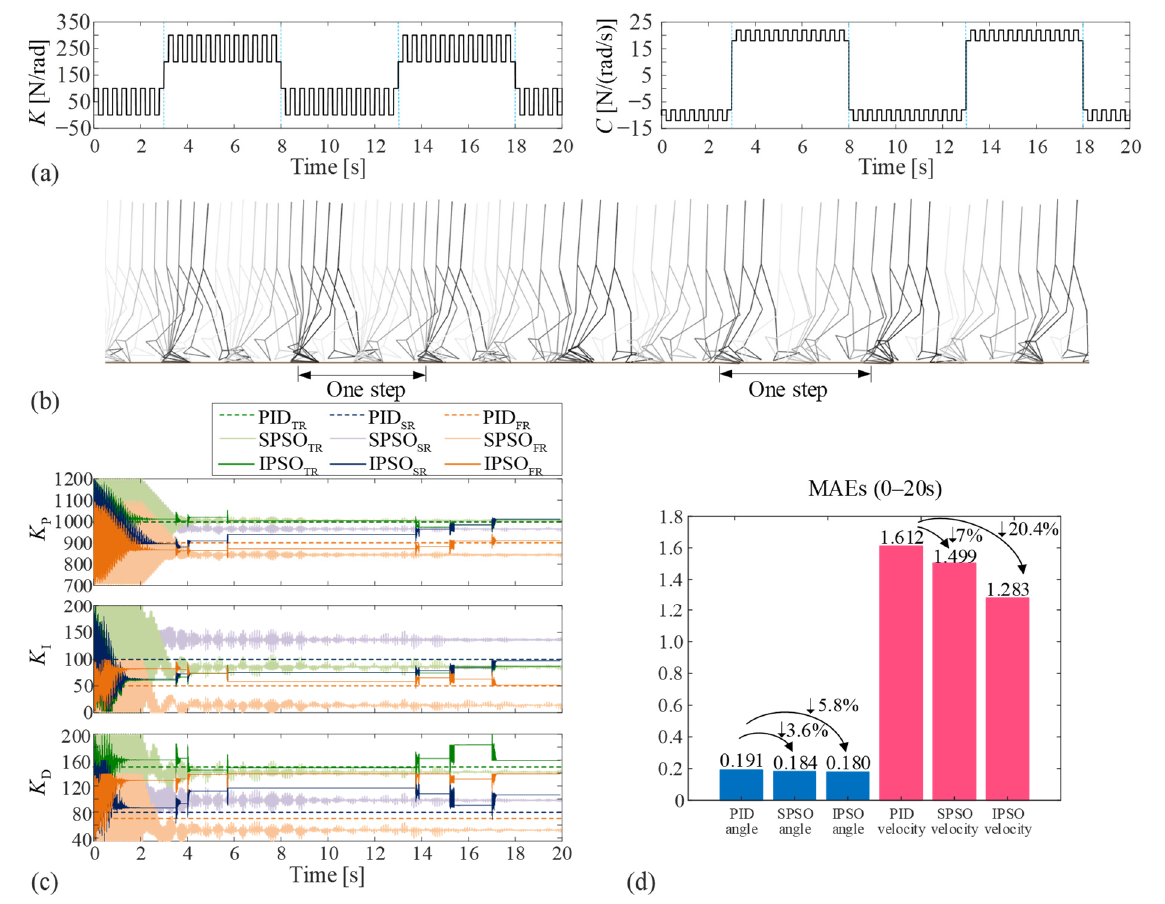
Figure 5. Tracking results of Case II. ( a ) Fast and slow variations of the stiffness and damping of the exoskeleton joints. ( b ) Stroboscopic view of dynamic walking with speed varies from 1.2 to 1.8 m/s. ( c ) Evolutions of the PID gains corresponding to the SPSO and the IPSO algorithms; for reference, the pre-tuned PID gains are also plotted. ( d ) Mean accumulated errors (MAEs) in the whole process (0–20 s). The reductions brought by the SPSO and the IPSO algorithms are denoted.